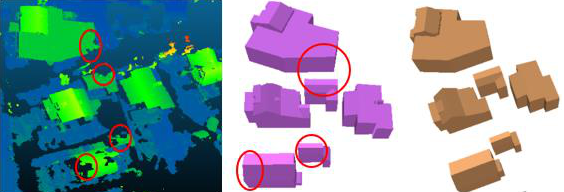
Figure 20. Showing missing data, UAV and ALS 3D